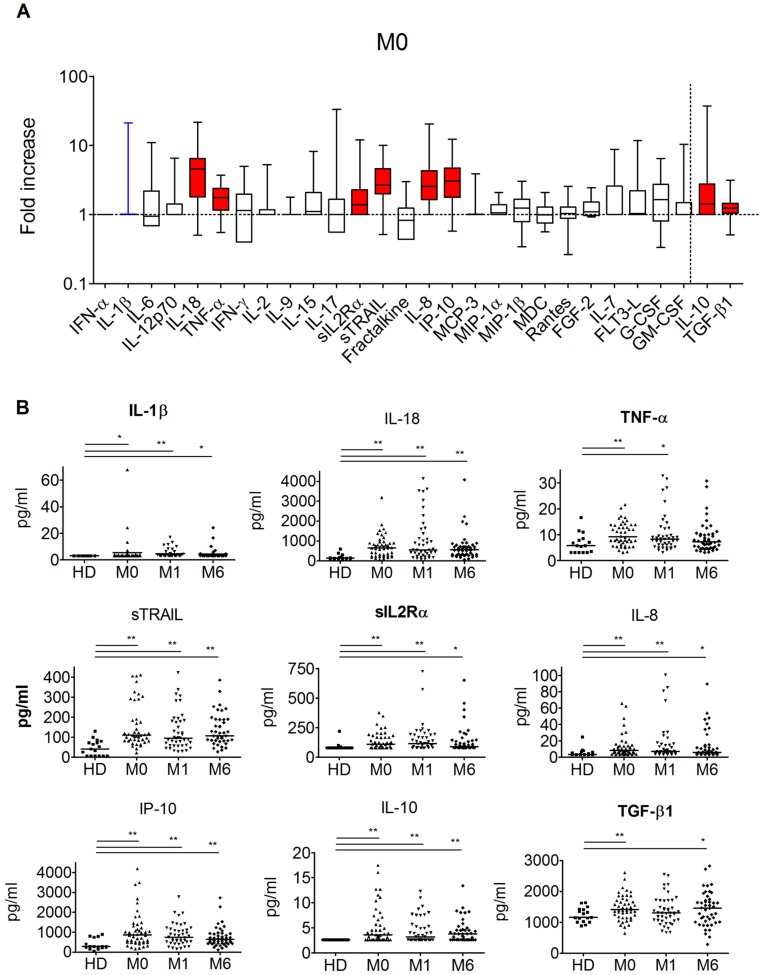
Plasma protein levels in HIV-1 infected patients.(A) The levels of 28 proteins in the plasma of 46 acutely infected patients (M0) are expressed as fold change compared to the levels in healthy donors (N = 17). The order of the proteins is presented according to their function (pro-inflammatory, adaptive, IFN-inducible, chemoattractants, hematopoietic and anti-inflammatory). The anti-inflammatory cytokines are presented on the right side of the figure. The dotted horizontal line at Y = 1 corresponds to the value in healthy donors. The boxes represent the median and the 25th and 75th percentile, with the line in the middle of the boxes corresponding to the median value. Colored boxes stand for the cytokines, whose levels were significantly different from healthy donors: blue boxes when p<0.05 (as it was the case for IL-1β) and red boxes when p<0.008 (M&W test). (B) Protein concentrations at M0, M1 and M6 of the soluble factors that were elevated at M0. The data are expressed in pg/ml, HD: healthy donors, M: months. Cytokine concentrations below the limit of detection were arbitrarily set at the level of the limit of detection. Dot-plots marked with one asterisk (*) (p<0.05) or two asteriks (**) (p<0.008) represent the cytokines, whose levels were significantly different from healthy donors (M&W test).